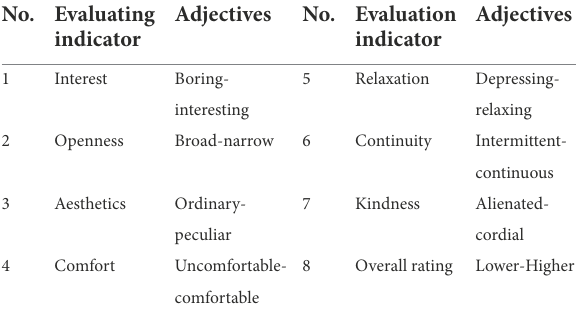
TABLE 6 Quantifiers of spatial psychological cognitive